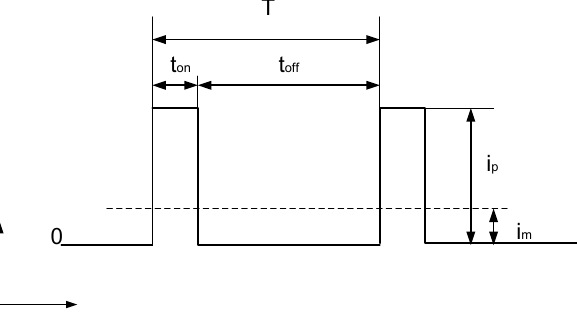
Figure 1: Schematic diagram of the square wave pulse